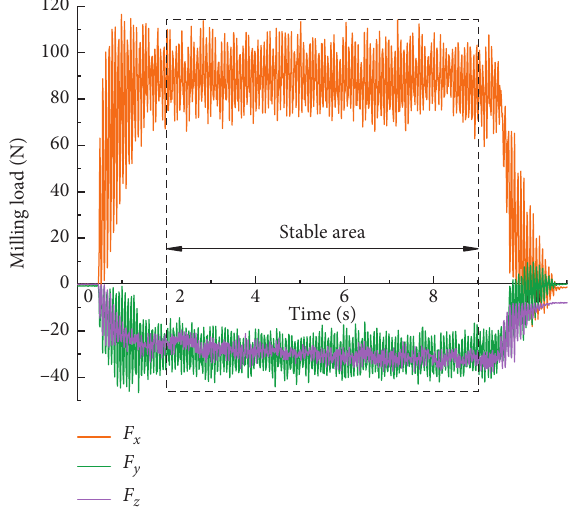
Figure 3: Signal images of the milling load component in three directions.